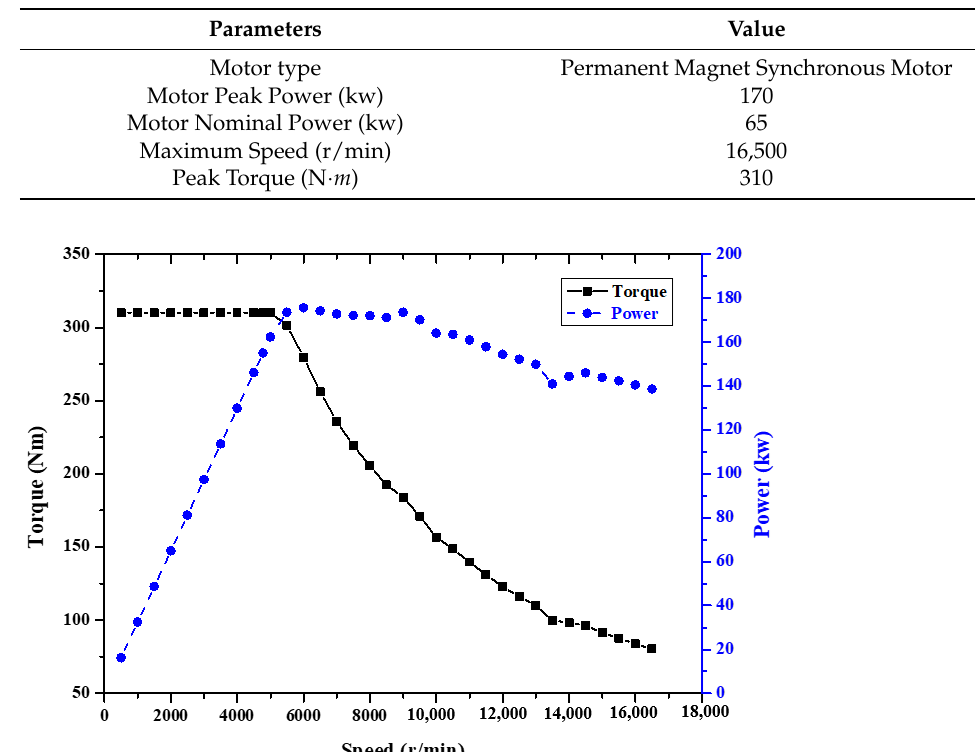
Table 2. Parameters of the electrical motor in this study.